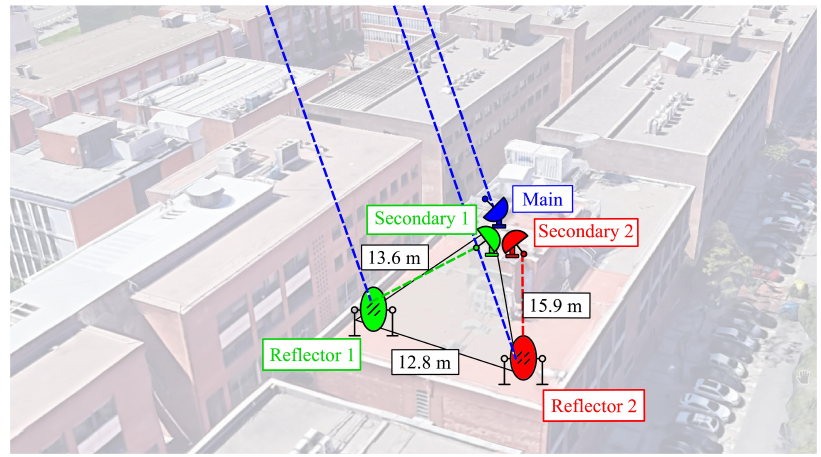
Figure 3. Air-view layout of the interferometric system. The satellite signal (blue dashed lines) is directly received by the main antenna and the mirror reflectors. The secondary antennas point to their corresponding mirrors, which reflect the satellite signal (green and red dashed lines). The reflectors allow increasing the baseline while keeping the receiver antennas very close, so they can share a common reference frequency with minimal phase drift error induced by temperature